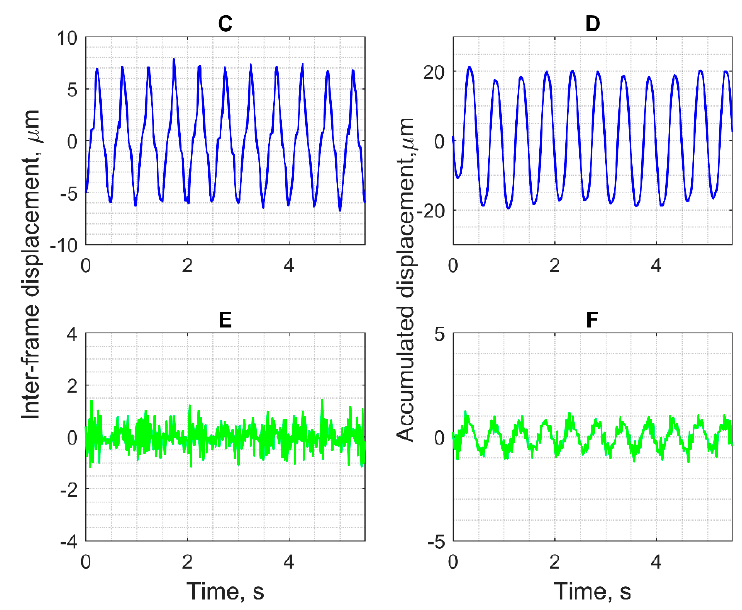
Figure 3. Results of the detection algorithm evaluation on targeted RF signals from the harmonic motion phantom: ( A ) B-mode ultrasound image of the phantom with the TMM; ( B ) map of motion: root mean square of the accumulated displacement signal d rms [ p ] represented in color scale. asterisks indicates the points in which weak (green asterisk) and intense (black asterisk) displacement signals were estimated; ( C , E ) displacement signals at weak and intense movements locations represented in the form of inter-frame displacements; ( D , F ) displacement signals at weak and intense movement locations represented in the form of accumulated displacements.